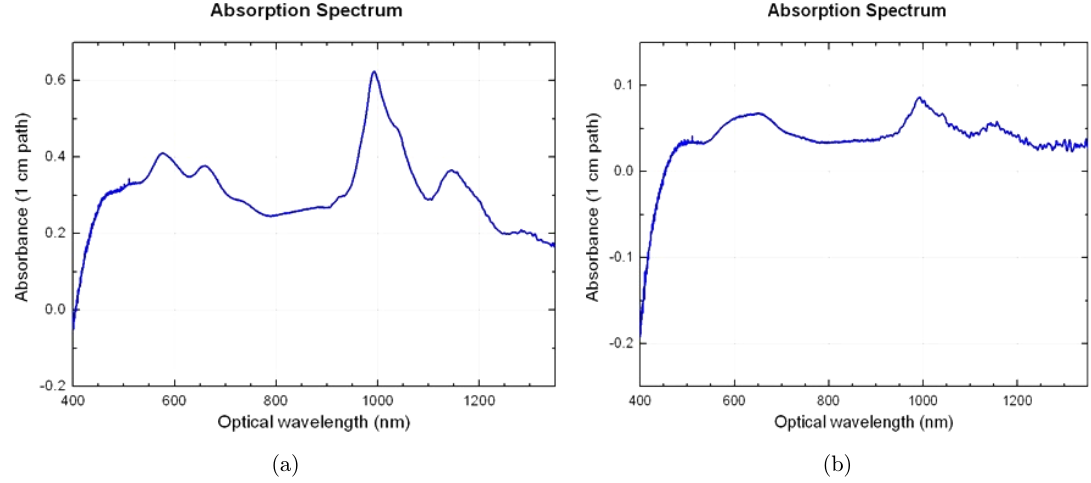
Fig. 2. Optical absorbency of SWNTs. Raman spectra of di®erent SWNT – GC solutions were collected from NS2 equipment at 532 nm and UV-Vis optical absorbance. (a) Raman spectrum of solution with lower SWNT concentration (3 mg SWNT in 7 mL GC, diluted 10 folds); (b) Raman spectrum of solution with lower SWNT concentration (3 mg SWNT in 7 mL GC, diluted 100 folds). (c) Raman spectrum of solution with higher SWNT concentration (15 mg SWNT in 7 mL GC, diluted 10 folds); (d) Raman spectrum of solution with higher SWNT concentration (15 mg SWNT in 7 mL GC, diluted 100